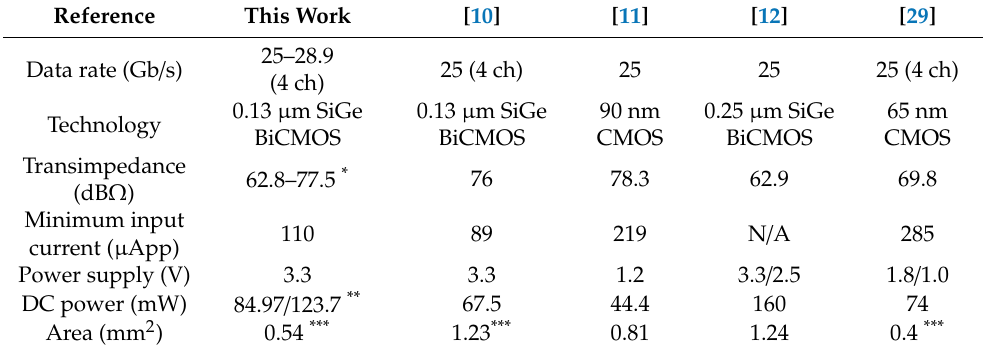
Table 2. A comparison of the performance with that in previously published works for one